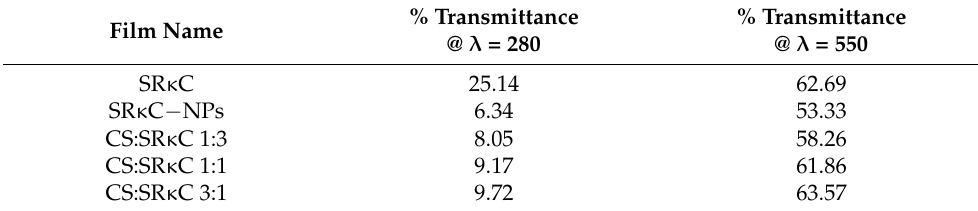
Table 3. Transmittance of bionanocomposite